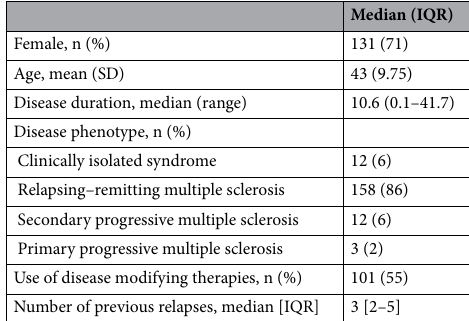
Table 3 summarises the parameters used to evaluate the performance of the association models for each outcome measure. The global disability, measured by the follow-up EDSS, was more closely related to the FA (RMSE = 0.839 and R 2 = 0.178) than the MD metrics. Similarly, motor functioning was more closely associated with the FA values, both in the ambulation measured by the T25FW (RMSE = 0.524 and R 2 = 0.304) and in the hand-motor